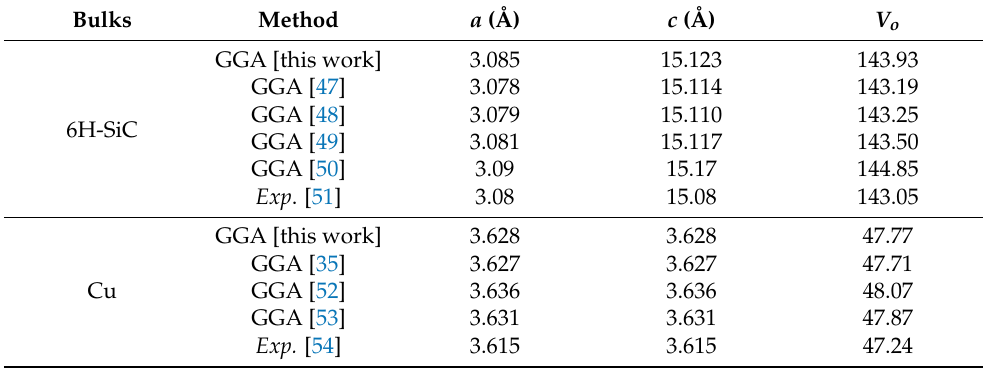
Table 1. Simulated and experimental cell parameters of the 6H-SiC and Cu bulks.